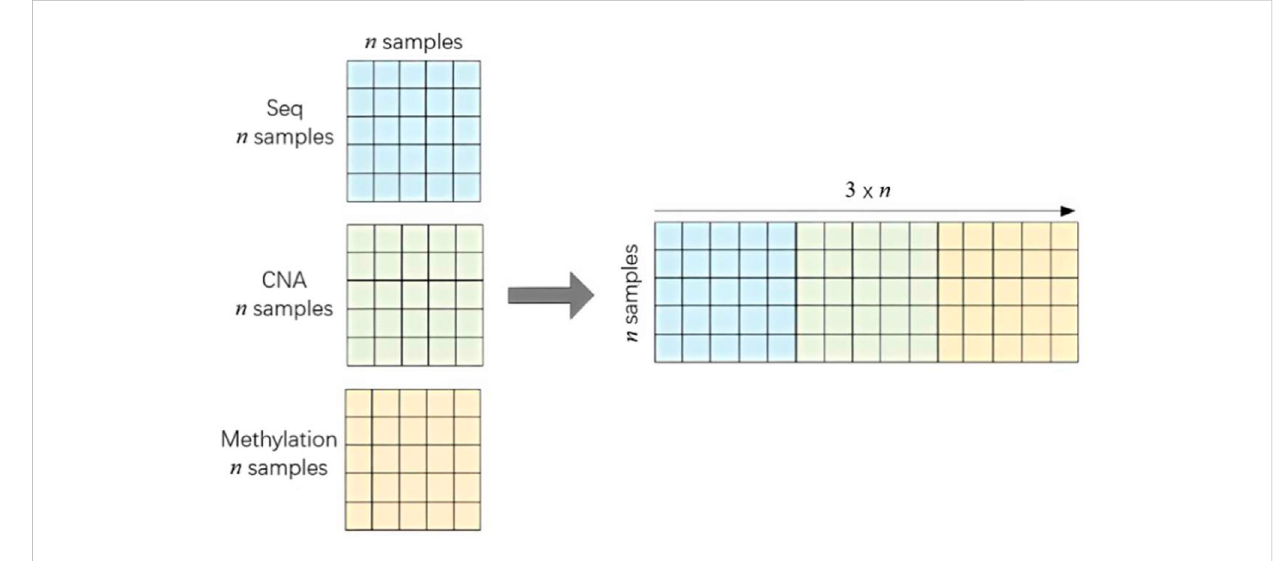
FIGURE 3 Integration of three similarity